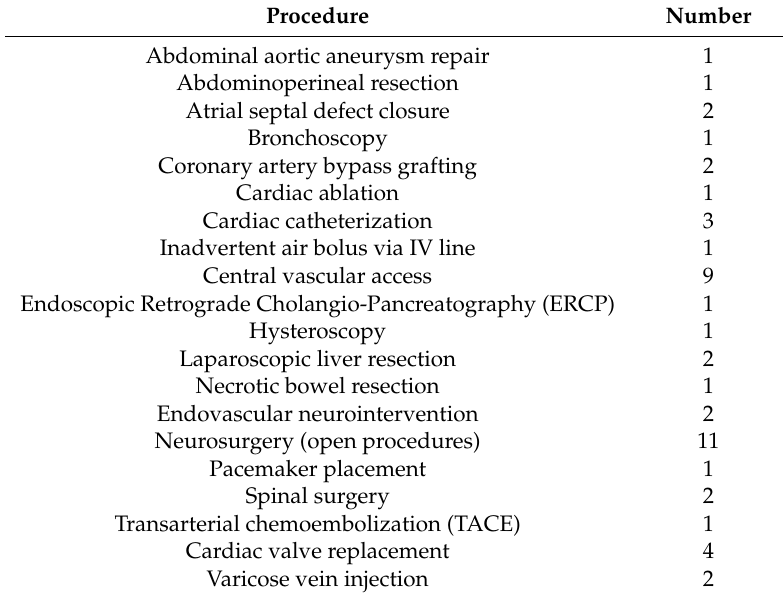
Table 2. Intraoperative/intra-procedural cases associated with air embolism.